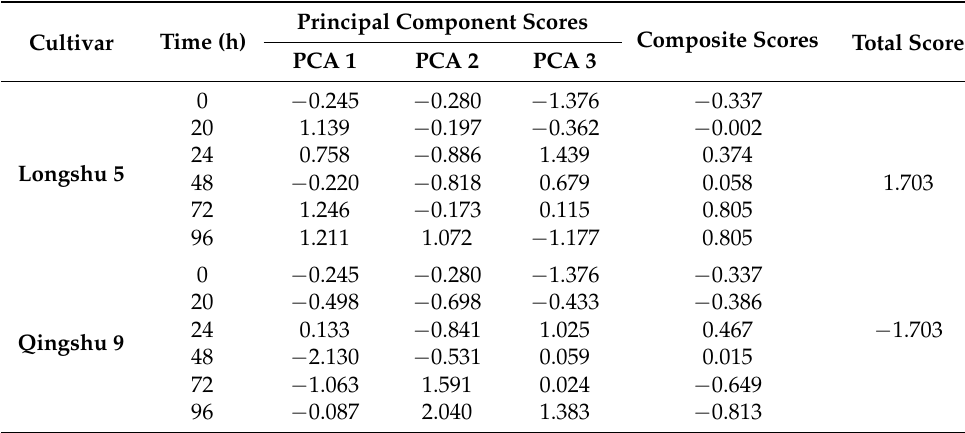
Figure 3. Three-dimensional load diagram of seven indicators. Z represents that the analysis is performed using normalized data. CAT, catalase; POD, peroxidase; SOD, superoxide dismutase; MDA, malondialdehyde; PCA, principal component. Table 4. Principal component and composite scores of the two cultivars.